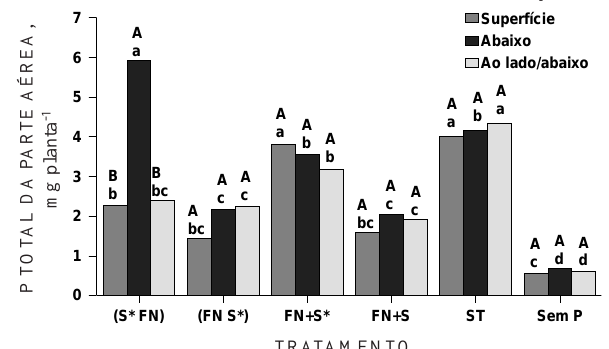
Figura 6. P total acumulado na parte aérea do jacatupé, nos tratamentos FN revestindo o enxofre inoculado com Acidithiobacillus (FN S*), FN revestido com S inoculado com Acidithiobacillus (S* FN), mistura FN com S inoculado com Acidithiobacillus (FN + S*), mistura FN com S sem Acidithiobacillus (FN + S), superfosfato triplo (ST) e sem adição de fósforo (sem P) de acordo com a localização do adubo. Letras minúsculas comparam as médias dos diferentes tratamentos com adição de P em cada modo de localização do adubo; as maiúsculas, cada tratamento com P nos diferentes modos de localização do adubo. C.V. % = 14,67.